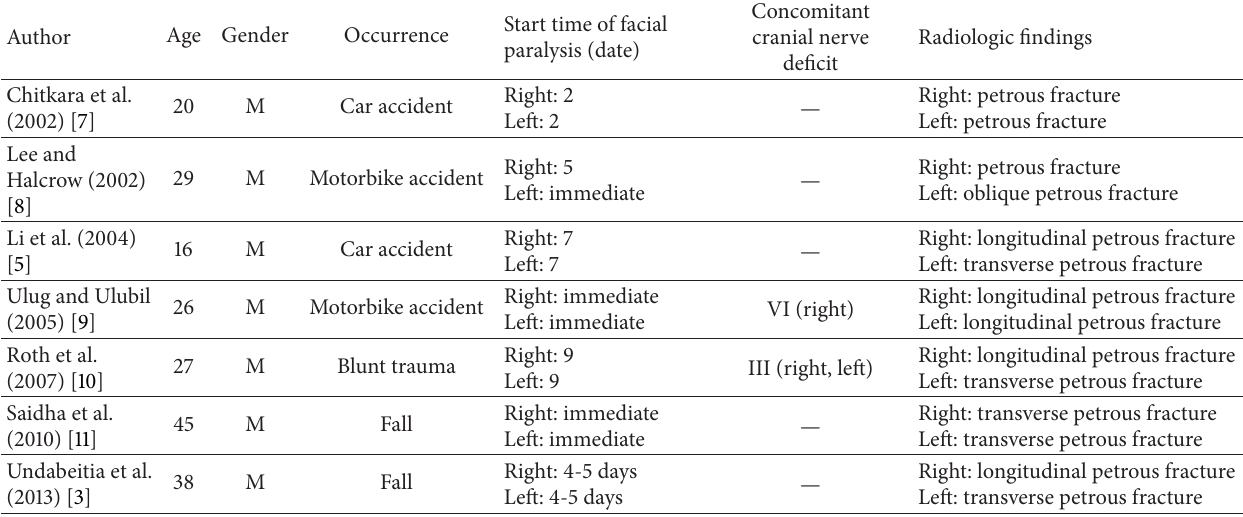
Table 1: Bilateral facial paralysis depending on bilateral temporal bone fractures described in